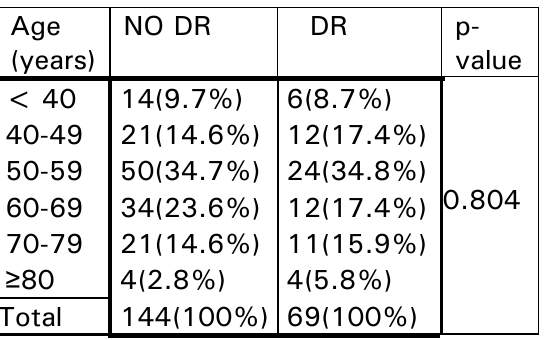
Table 3: Age wise distribution of DR